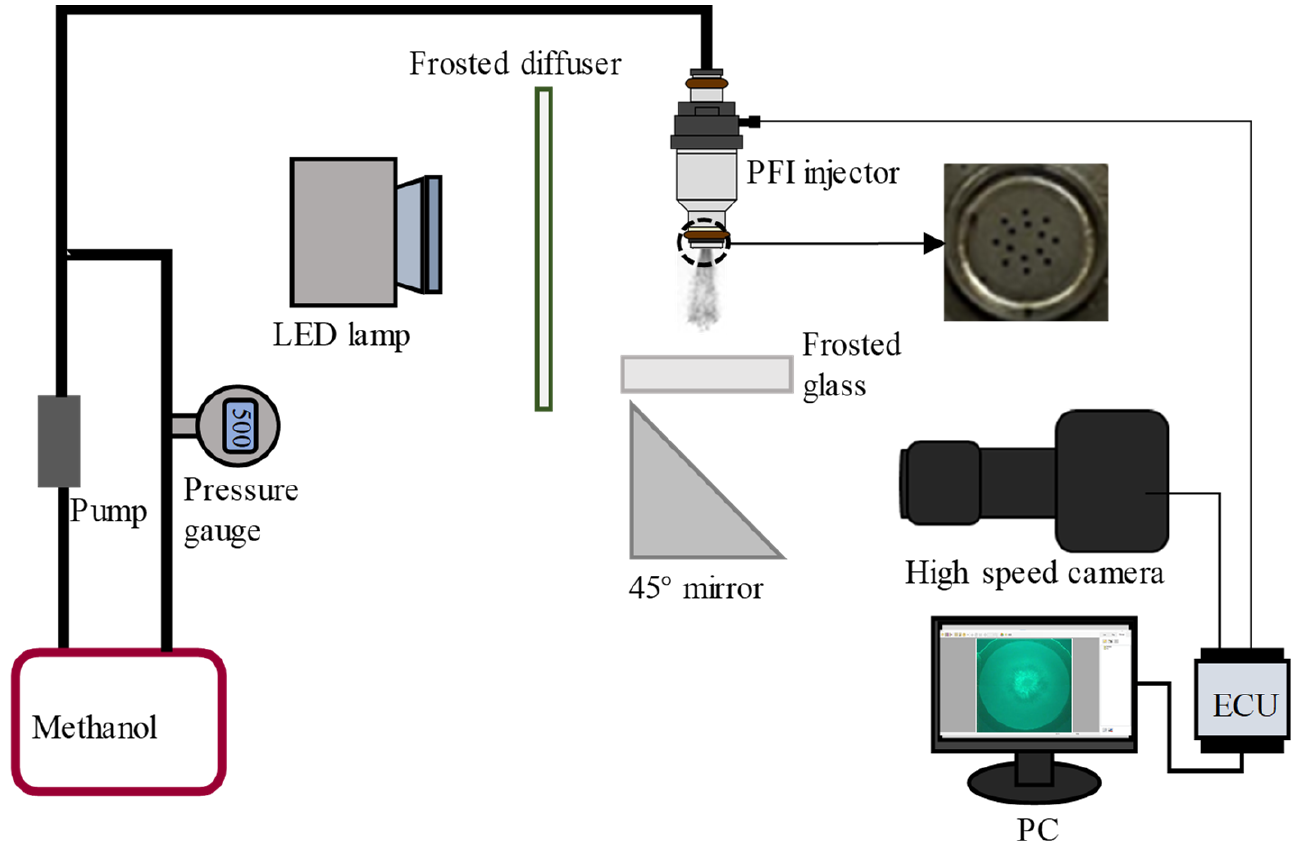
Figure 1. Schematic diagram of the experimental setup.